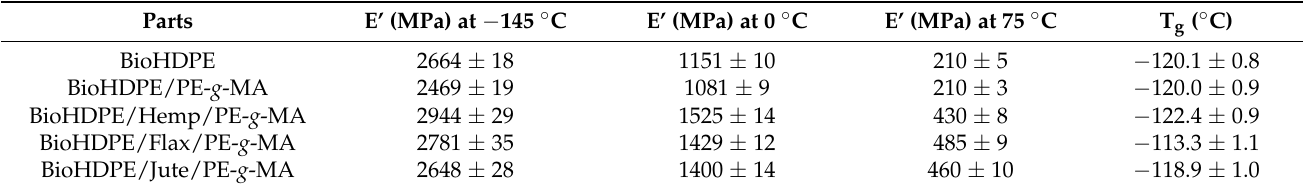
Table 5. Main thermomechanical properties of Bio-HDPE composites with different natural fibers obtained by dynamic mechanical thermal analysis (DMTA).